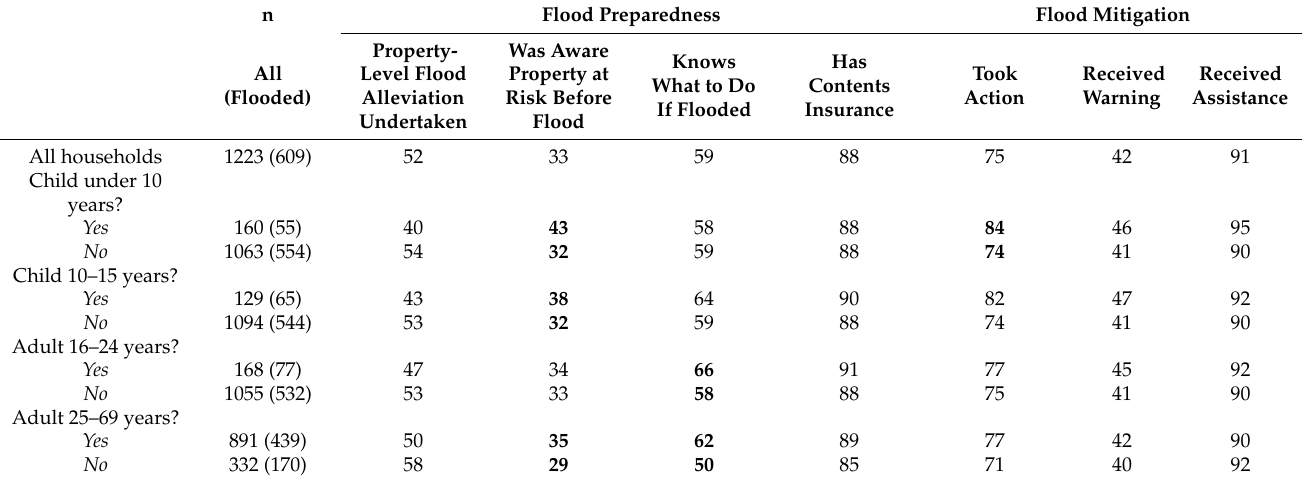
Table 2. Flood resilience by demographic and social characteristics. (% of